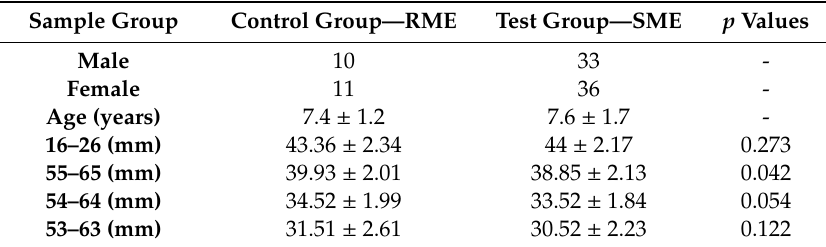
Table 1. Starting form comparison (T0 RME vs. T0 slow maxillary expander—SME).